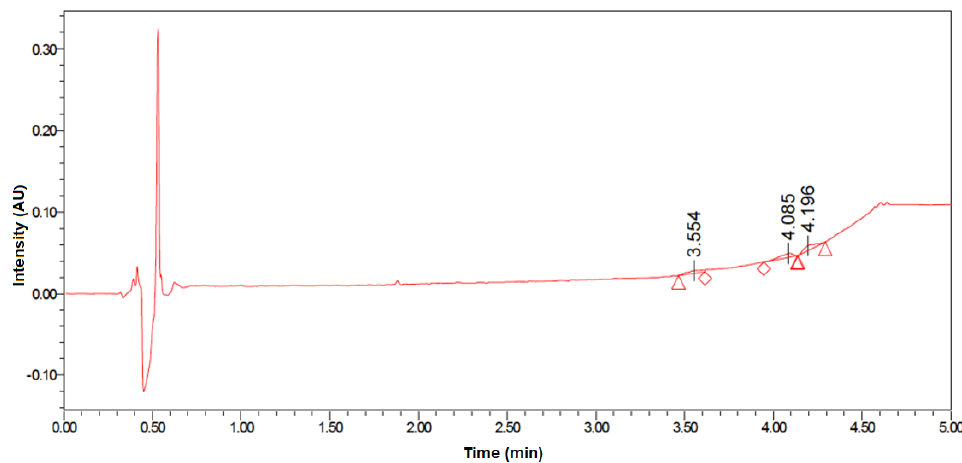
Figure 5. Skin penetration of B1 from 50% transcutol formulation detected via UV-UPLC after 24 h. No penetration of B1 through dog skin is observed (UV-UPLC detection limit: 1 µ g/L). Since B1